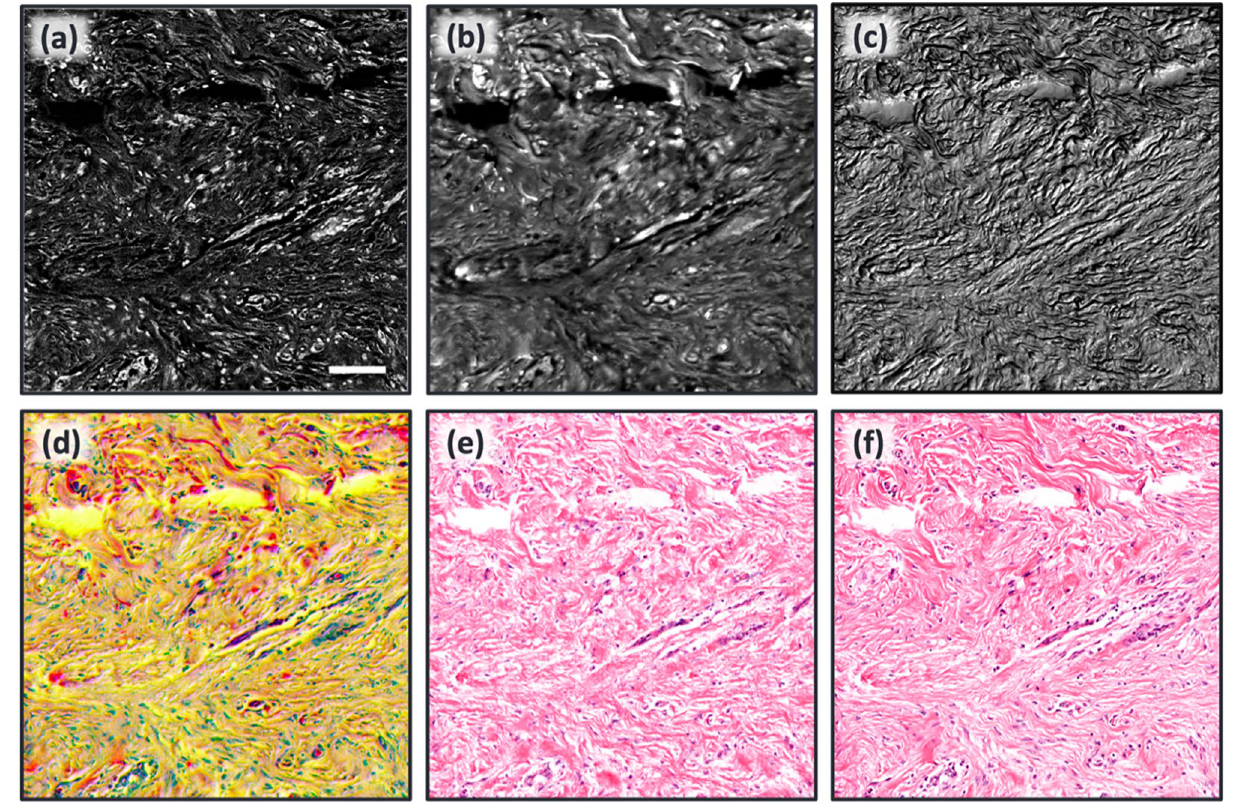
Figure 4. The colorization network input and output images of human skin tissue slide. ( a ) TA-PARS non- radiative absorption contrast image captured using a TA-PARS microscope. ( b ) TA-PARS radiative absorption contrast of the same tissue using the same microscope. ( c ) TA-PARS optical scattering contrast. ( d ) TA-PARS image of all three channels (network input to be colorized). ( e ) Colorized TA-PARS image using Pix2Pix model. ( f ) Histologically stained tissue of the same region taken on a bright field microscope, the ground truth for the virtual staining framework. Scale bar: 100